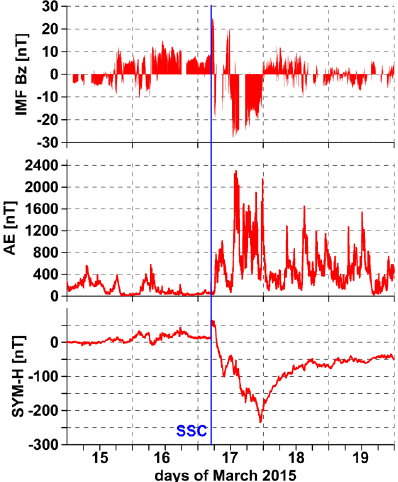
Figure 3. Time series of the selected geomagnetic indices during 15 – 19 March 2015 (based on OMNI database: http://omniweb.gsfc.nasa.gov).